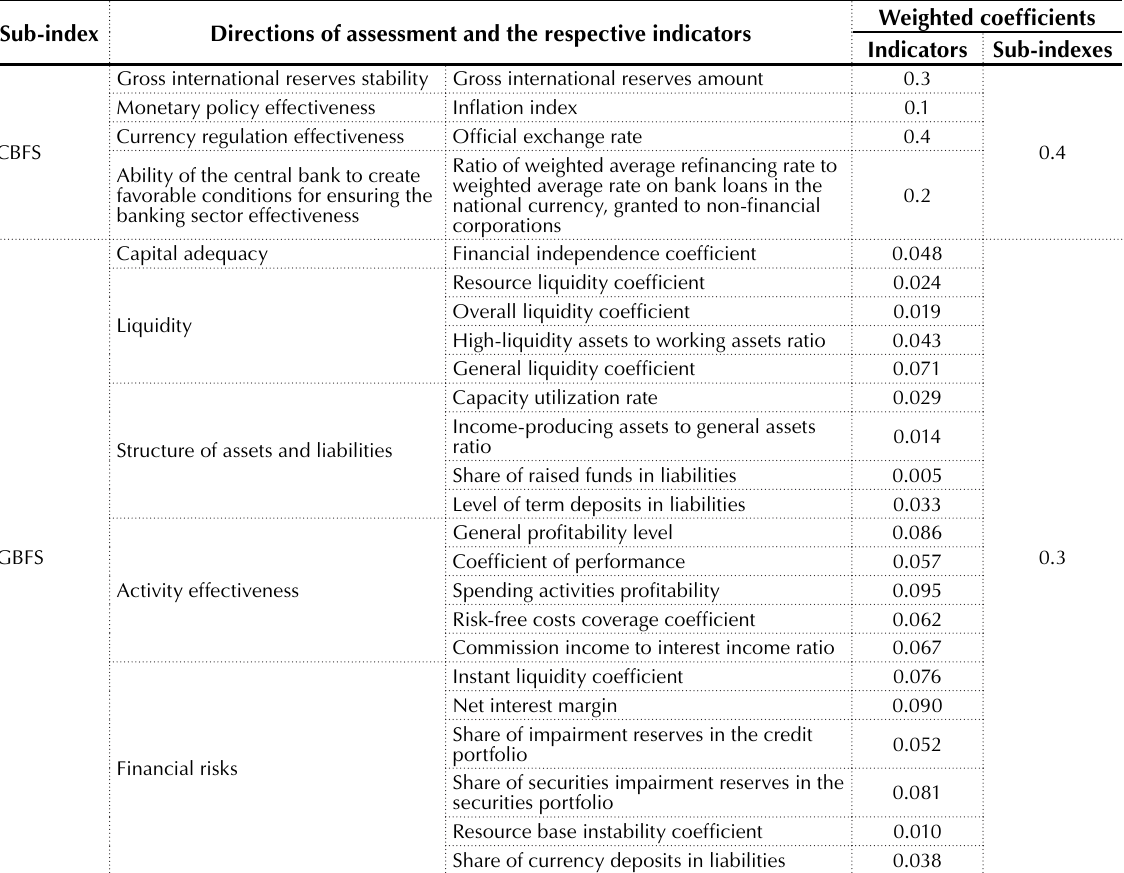
Source: Calculated by the authors.